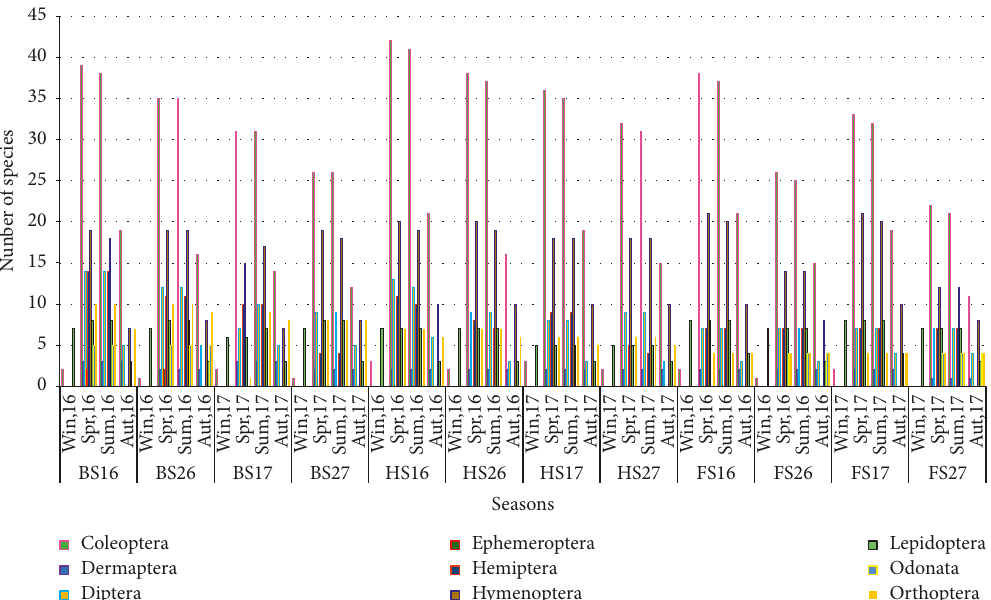
Figure 6: Seasonal variation of insect fauna recorded from stations during the study period